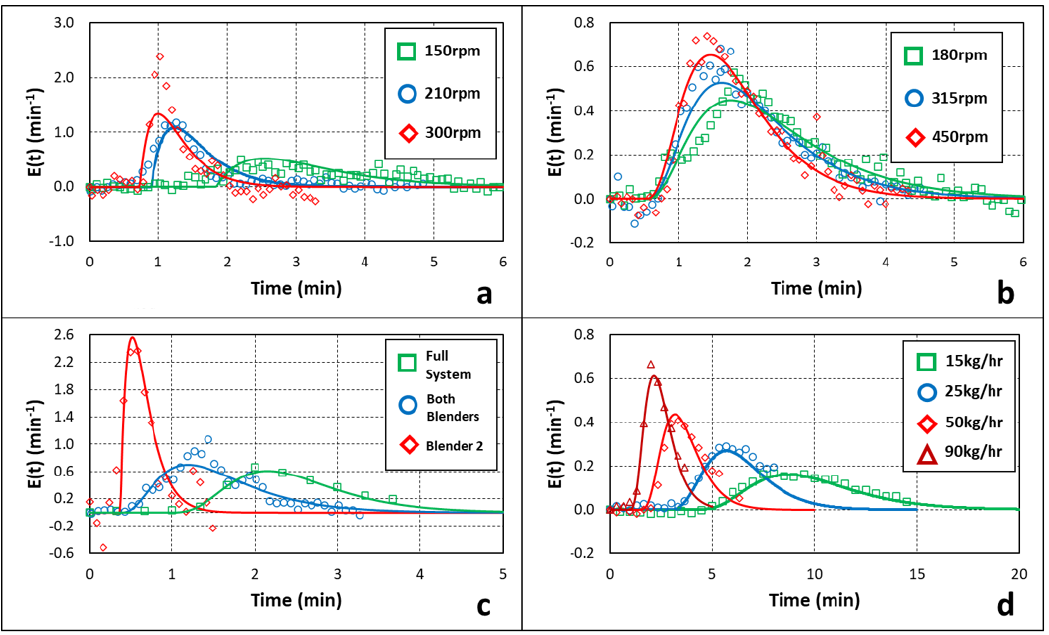
Figure 9. Impulse experimental results by mass flow. ( a ) Blender 2 pulses at 25 kg/h with varying Blender 2 impeller speed. ( b ) Blender 1 pulses at 50 kg/h with varying Blender 1 speed and constant Blender 2 speed. ( c ) Blender 2, Blender 1, and full-system pulses at 90 kg/h. ( d ) Full-system pulses at 15 kg/h, 25 kg/h, 50 kg/h, and 90 kg/h.